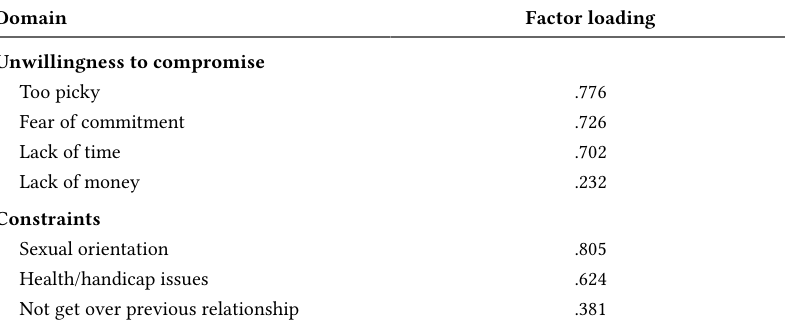
Significant Gender and Age Effects for the Three Extracted Domains